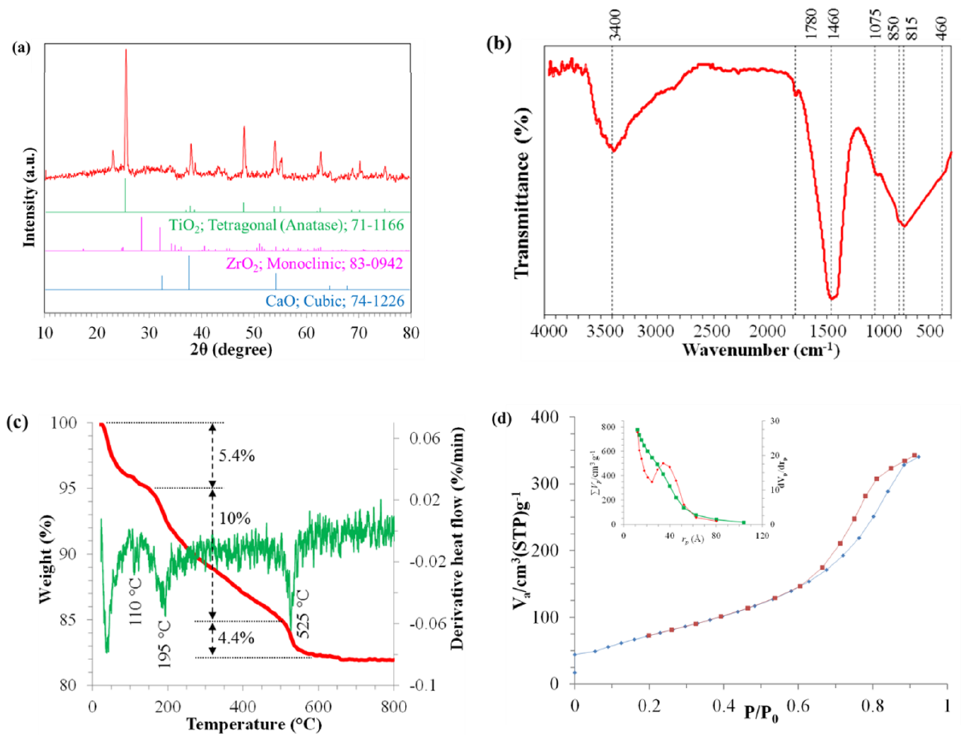
Figure 6. ( a ) XRD profile ( b ) FTIR spectrum, ( c ) TGA-DTA curves and ( d ) BET-BJH profile of calcium/titania-zirconia catalyst.